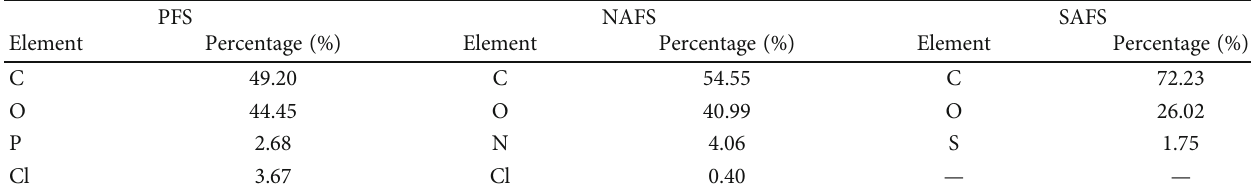
Table 1: EDX chemical composition comparison study of fennel seed